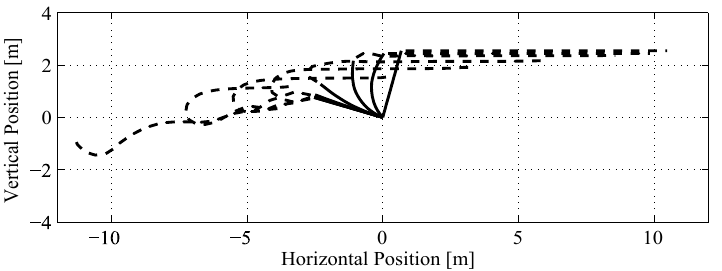
Fig. 13. Fly rod/line time history during a cast, where t = [0,0.15,0.2,0.3,0.4,0.5,0.6,0.75] s, and fl y rod butt at origin [Flexible Rod Case].